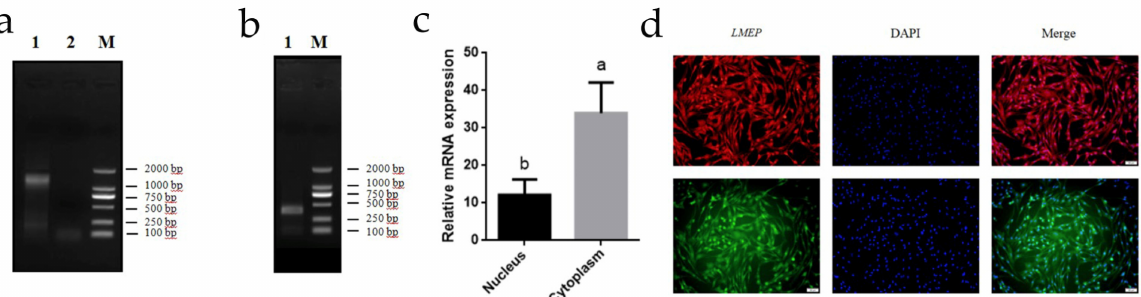
Figure 6. RACE and Subcellular Localization Identification of LMEP . ( a ) Results of LMEP full-length sequence amplification by RACE PCR. One and two represent 3 (cid:48) RACE, while M represents DL2000 Markers. ( b ) One represents the 5 (cid:48) RACE, while M represents DL2000 Marker. ( c ) Identification of the subcellular localization of LMEP by nuclear and cytoplasmic analysis. ( d ) FISH experiments to identify the subcellular localization of LMEP . The different letters represent significant differences ( p < 0.05), and the same letters show no significant difference ( p > 0.5), which is the same as it is